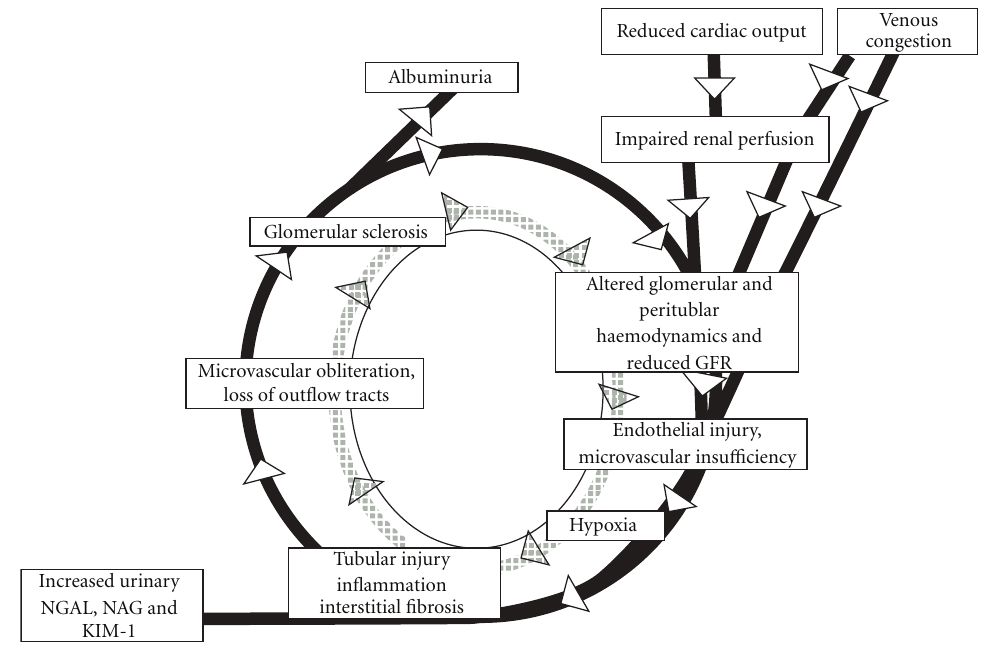
Figure 2: Hypothetical vicious circle of decreased glomerular function, endothelial injury, and tubular damage in heart failure. GFR: glomerular filtration rate. NGAL: neutrophil gelatinase associated lipocalin. NAG: N-acetyl-beta-D-glucosaminidase. KIM-1: kidney injury molecule 1. Adapted and reprinted with permission from Norman and Fine [59] and Damman et al.